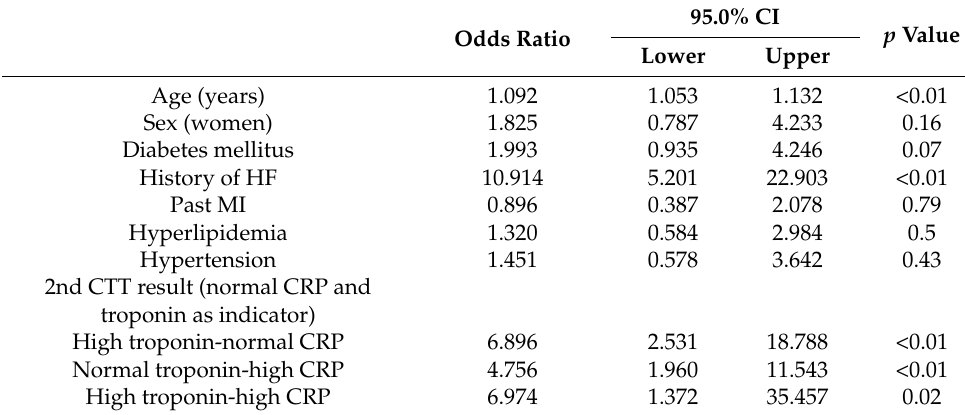
Table 2. Binary logistic regression to predict 30-day